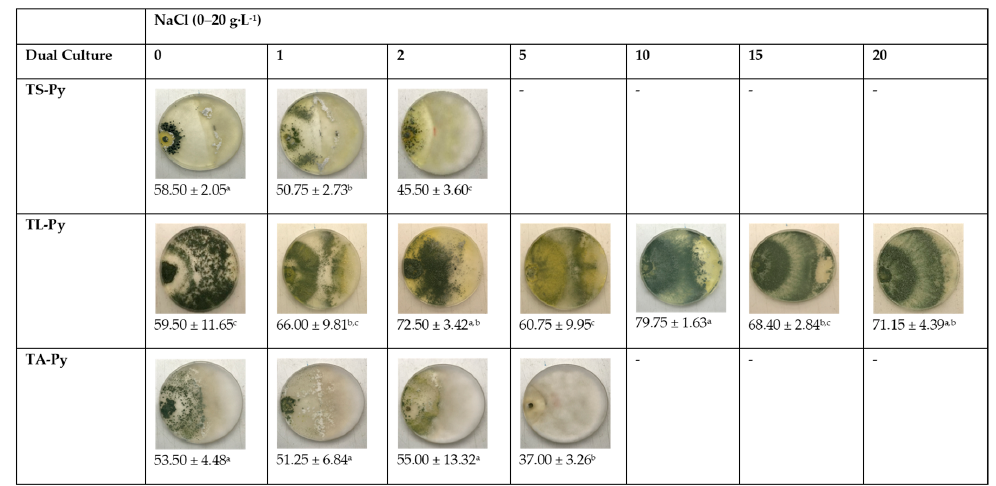
Figure 3. Antagonistic potential of Trichoderma isolates against P. ultimun (Py) in dual culture at different salinity levels on potato dextrose agar (PDA) medium. % mycelial inhibition was calculated